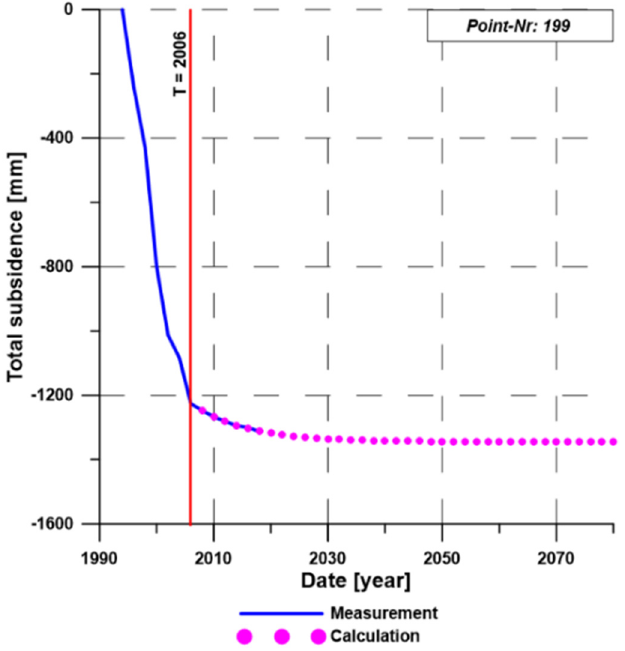
Figure 8. The course of subsidence until 2018 and the prediction of residual subsidence for the point no. 199.